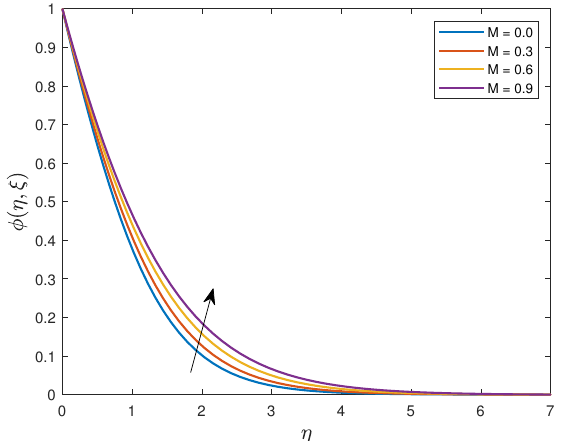
Figure 30. The influence of M on fluid